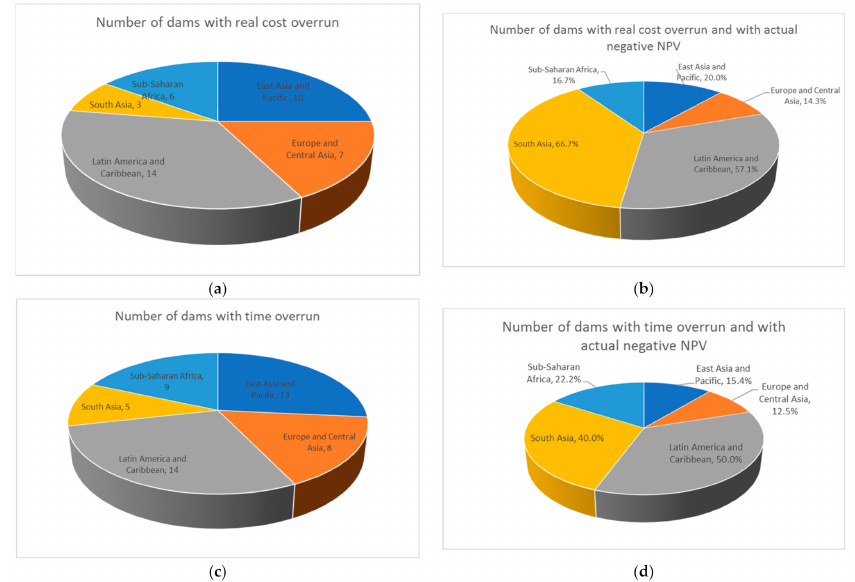
Figure 3. Projects with cost and time overruns across various regions: ( a ) Number of dams with real cost overrun; ( b ) Number of dams with real cost overrun and with actual negative NPV; ( c ) Number of dams with time overrun; ( d ) Number of dams with real cost overrun and with actual negative